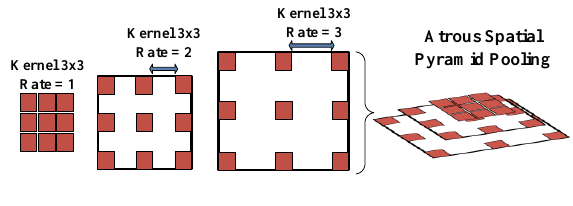
Figure 1. Atrous Spatial Pyramid